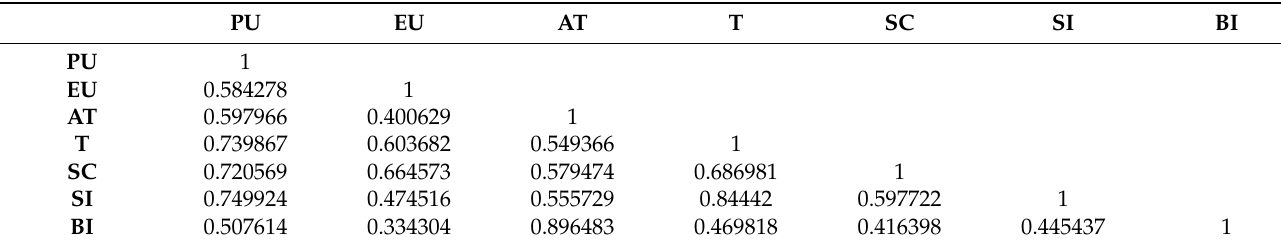
Table 10. Correlation between TAM variables.